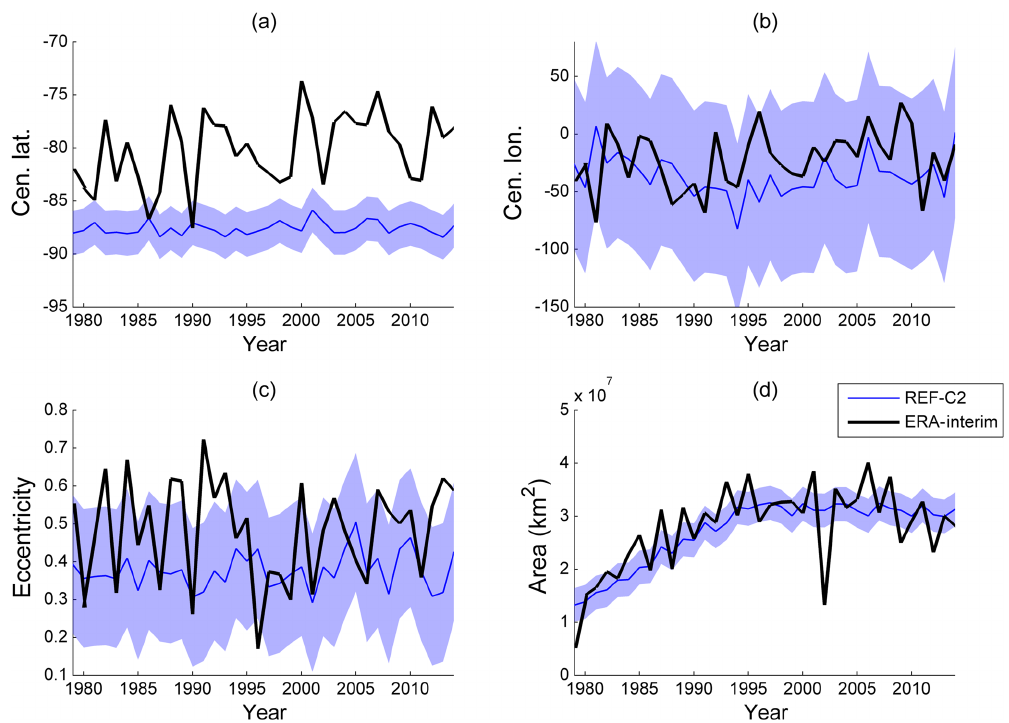
Figure 1. Time series of the October TCO ellipse parameters: (a) centre latitude, (b) centre longitude, (c) eccentricity and (d) area for the REF-C2 (blue) and ERA reanalysis (black). The shaded region indicates ± 2 SDs from the ensemble mean.